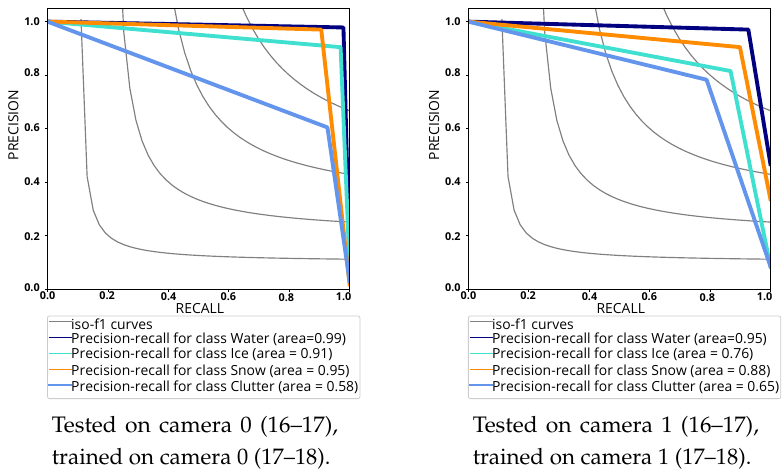
Figure 17. Precision-recall plots (St. Moritz) of cross-winter experiments. Best if viewed on screen. Table 19. Results (IoU) of cross-lake experiments. Cameras 0 and 2 monitor lakes St. Moritz and Sihl respectively.